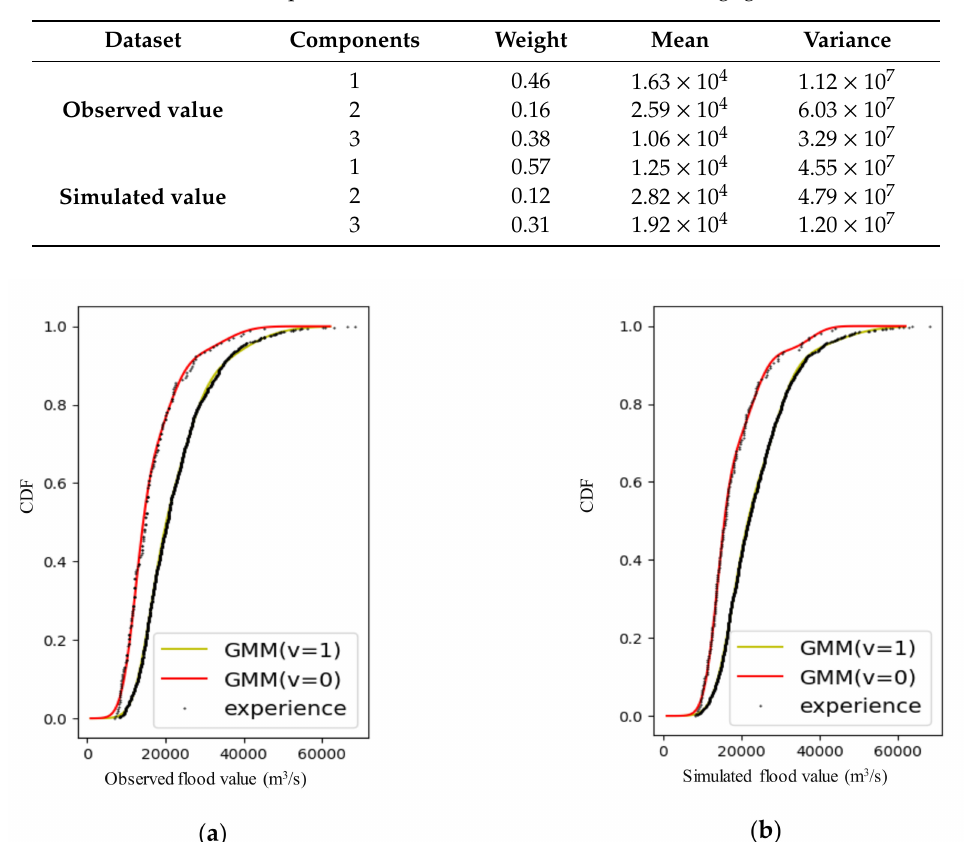
Table 3. Estimated parameters of GMM distributions under negligible rainfall.